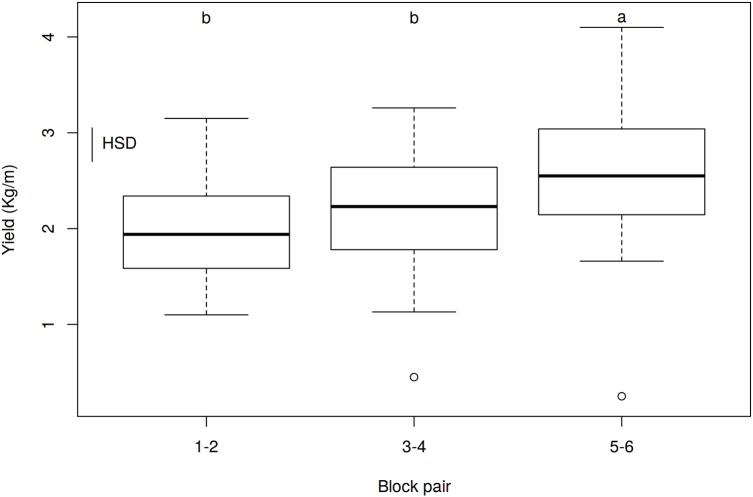
Effect of watering by block pairs on yield (kg/m).HSD, honestly significant difference = 0.3514 kg/m. Boxes show the 25th and 75th percentiles. Lines in the boxes show the median values; columns with a different letter are significantly different at p ≤ 0.05 (HSD).